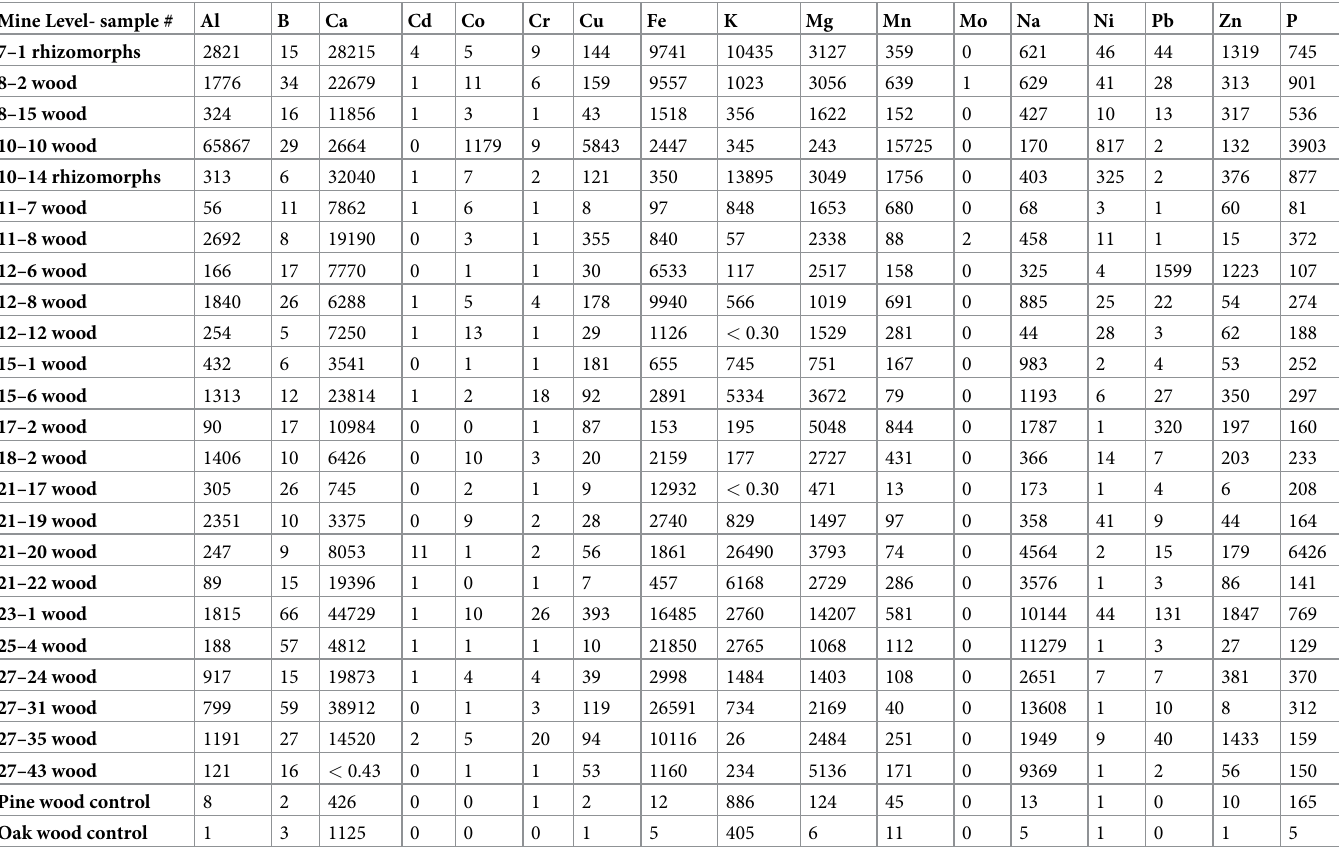
Table 2. Elemental analysis (ppm) of woods and Armillaria rhizomorphs collected from various levels of the Soudan iron ore mine and control sound wood used for